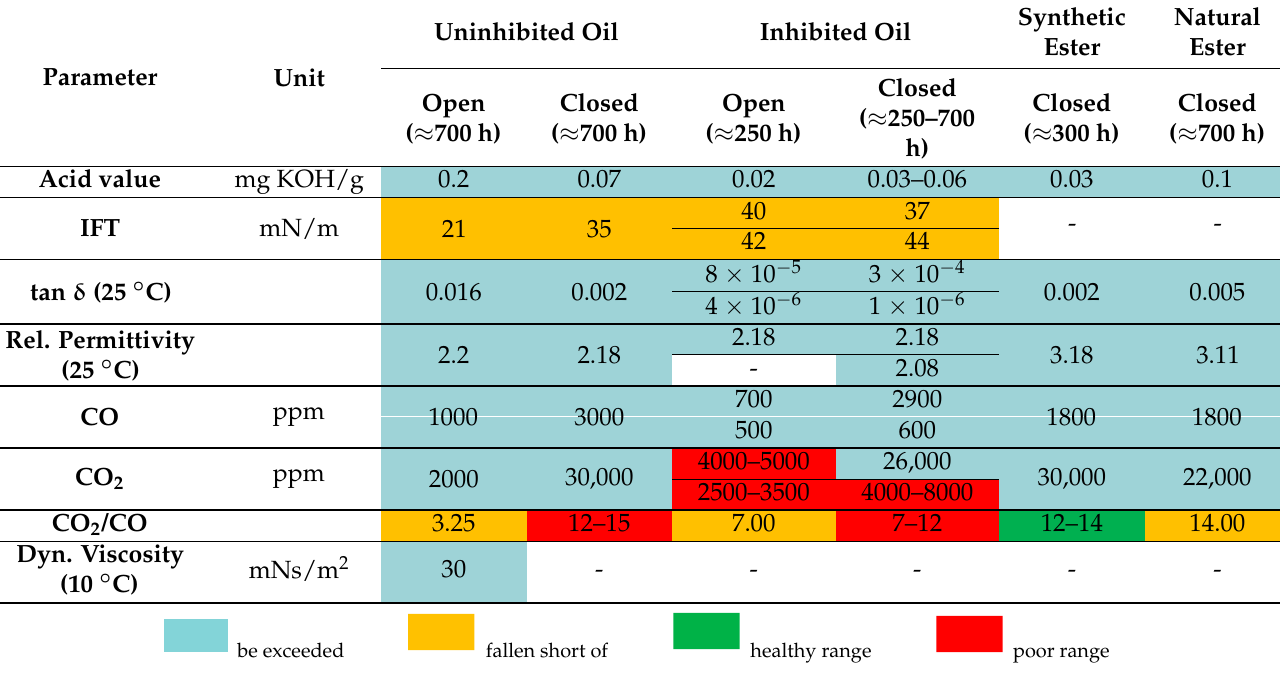
Table 4. Definition of threshold values for different transformers and liquids for 650 DP (In case of two threshold values per parameter, the upper value stands for Oil B and the lower for Oil C).